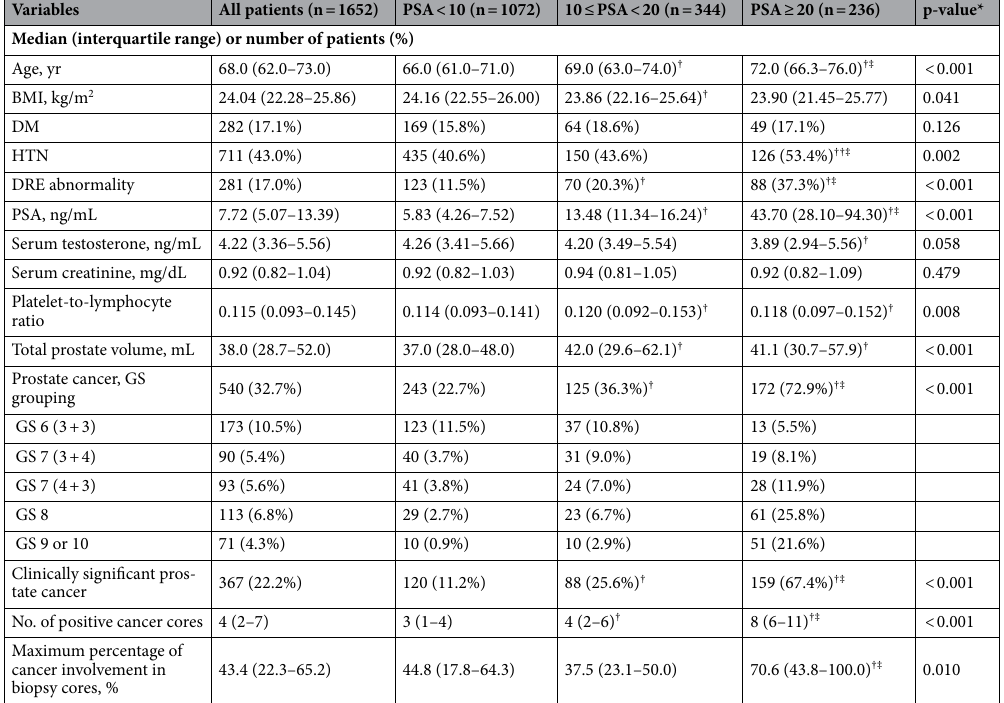
Table 1. Baseline characteristics of men who underwent standard 12-core TRUS-Bxs. BMI body mass index, DM diabetes mellitus, HTN hypertension, DRE digital rectal examination, PSA prostate-specific antigen, GS Gleason score, No. number, yr years. *p < 0.05: comparison of the variables between the groups using the Kruskal–Wallis test, the chi-squared test, or Fisher’s exact test, as indicated. † p < 0.05: compared to the group with PSA < 10 using the Mann–Whitney U test, the chi-squared test, or Fisher’s exact test, as indicated. ‡ p < 0.05: comparison between the groups with 10 ≤ PSA < 20 and PSA ≥ 20 using the Mann–Whitney U test, the chi-squared test, or Fisher’s exact test, as